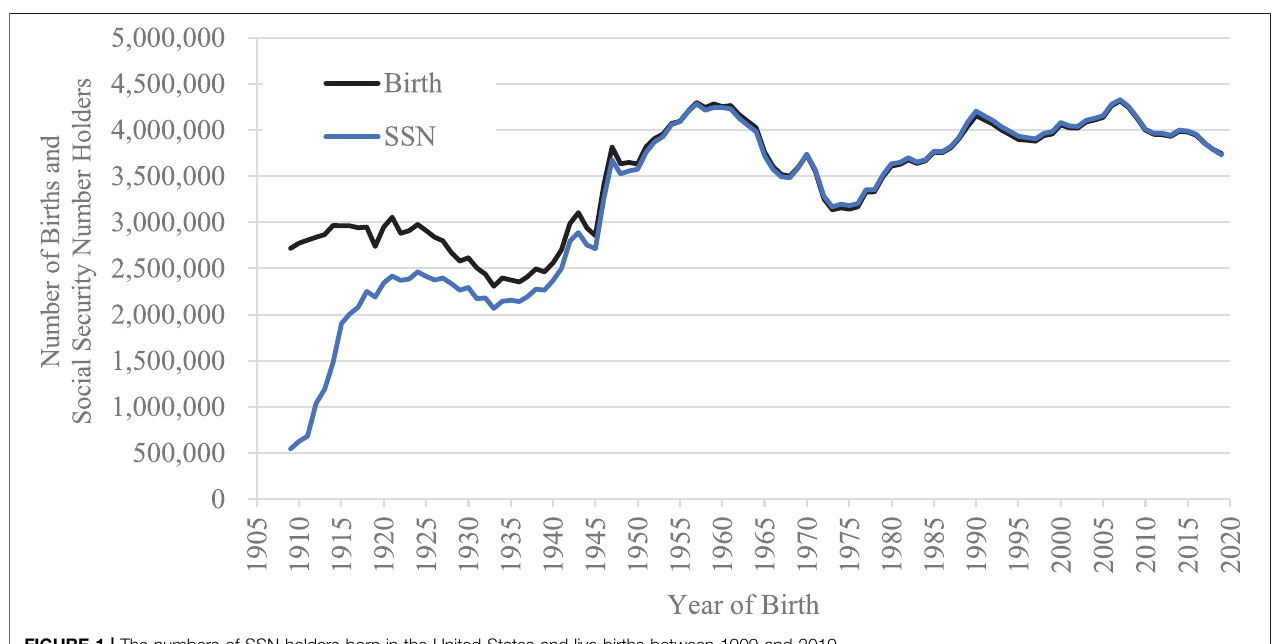
FIGURE 1 | The numbers of SSN holders born in the United States and live births between 1909 and